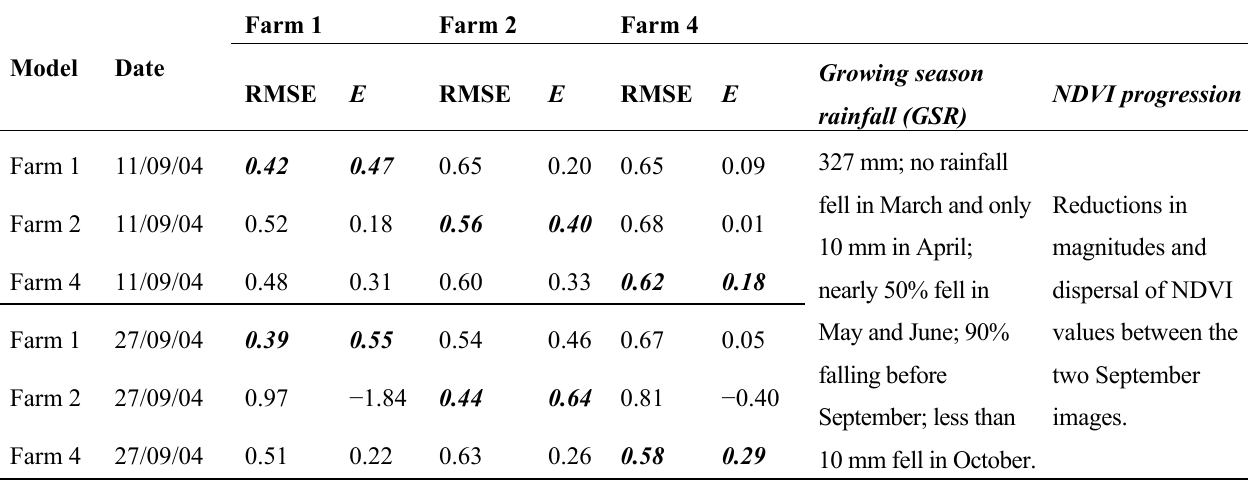
Table 8. Model and yield prediction efficiency criteria for 2004 Landsat imagery-Root Mean Square Error (RMSE) and the Nash-Sutcliffe Efficiency Criteria ( E ). Values in bold italics represent efficiency criteria for the calibration models. Descriptions of 2004 Growing season rainfall, NDVI progression and interpretations of